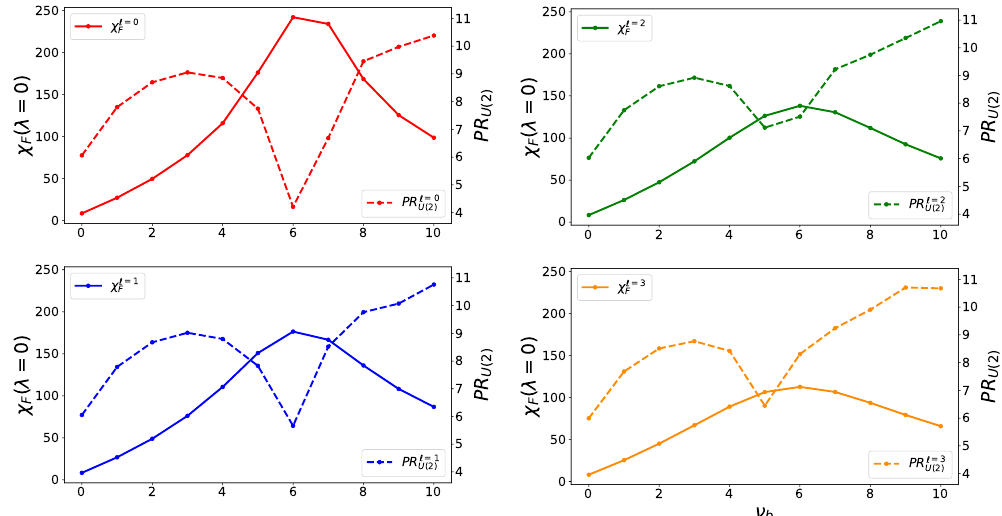
Figure 5: Si C bending eigenstates QFS (solid line) and PR in the U ( 2 ) basis (dashed 2 line) evaluated for λ = 0 versus the bending quantum number ν and orange lines correspond to (cid:96) = 0, 1, 2, and 3,